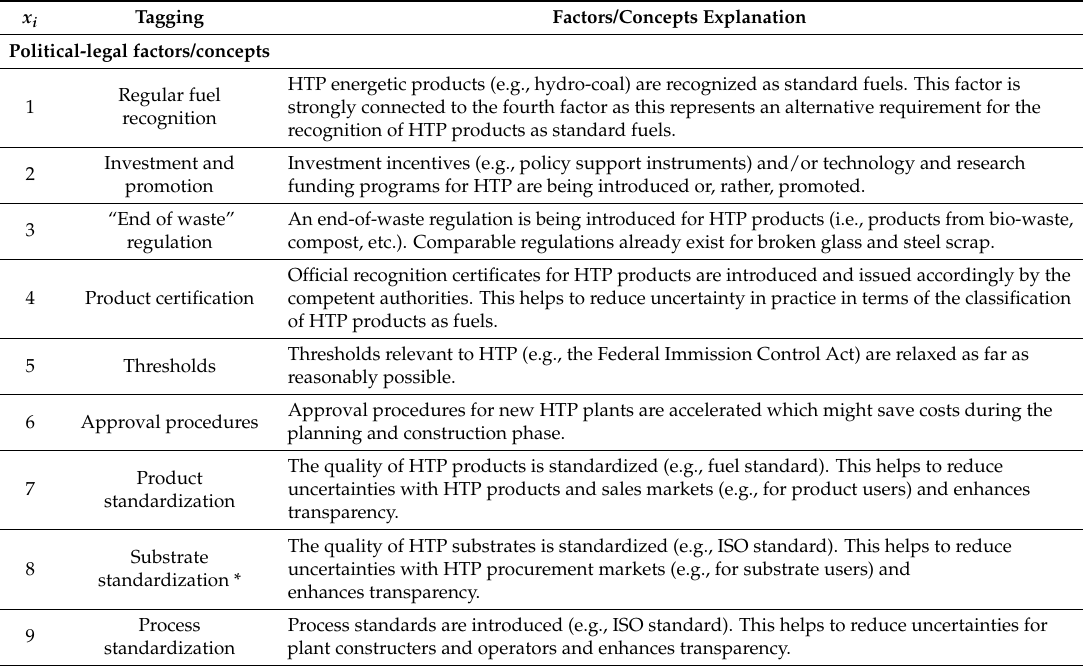
Table A1. “Long list” of factors for HTP development in Germany by